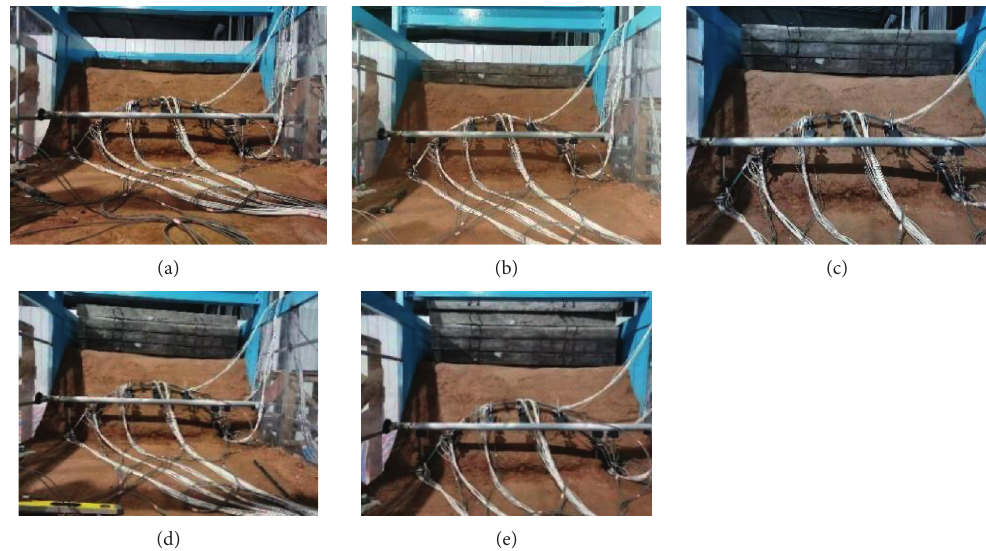
Figure 20: Process of loading: (a) Level 1; (b) Level 2; (c) Level 3; (d) Level 4; (e) Level 5.